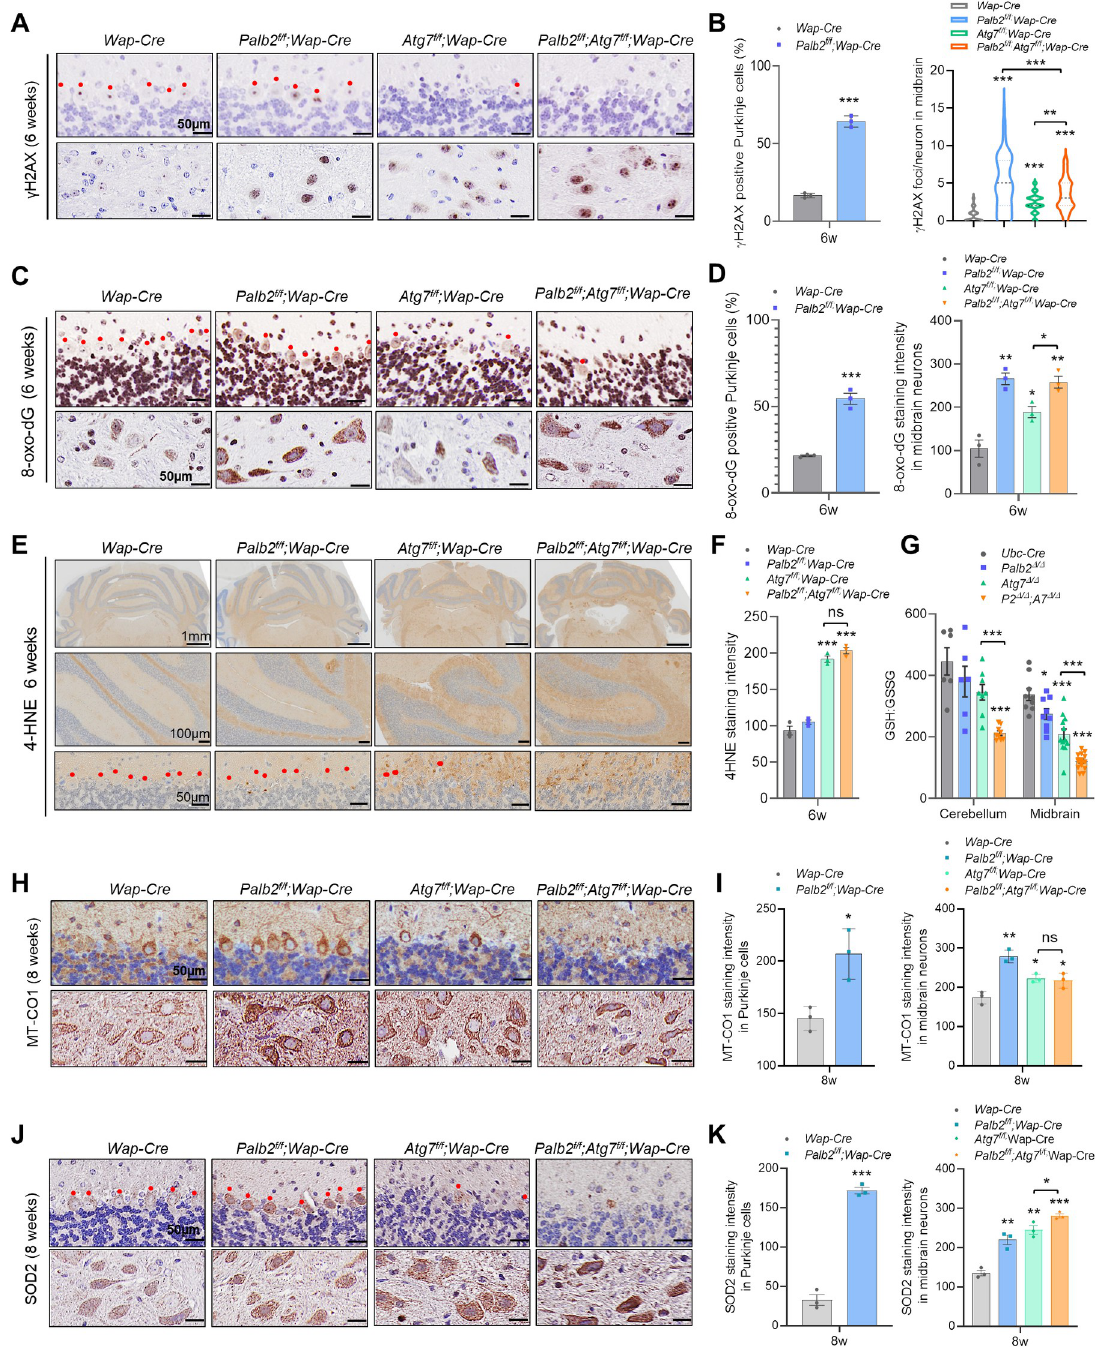
Fig 3. Increased DNA damage and oxidative stress and mitochondrial markers in Purkinje cells of Palb2 and Atg7 deletion mice. (A-D) Representative IHC images and quantification of DNA DSB marker γ H2AX (A and B) and oxidative DNA damage marker 8-oxo- dG (C and D) in cerebellum/Purkinje cells (upper images) and midbrain neurons (lower images) of the Wap-Cre driven CKO mice at 6 weeks. n = 3 mice per genotype. (E and F) Representative IHC images and quantification of lipid peroxidation marker 4-HNE in the cerebellum of the CKO mice at 6 weeks of age. Scale bar = 50 μ M. n = 3 mice per genotype. (G) GSH:GSSG ratios in the cerebellum and midbrain of Ubc-Cre-ERT2 driven WBKO mice. GSH and GSSG were measured by LC–MS/MS at 4 weeks after tamoxifen injection. n = 6–9 for cerebellum and n = 9–15 for midbrain. (H-K) Representative IHC images and quantification of MT-CO1 (H and I) and SOD2 (J and K) in cerebellum/Purkinje cells (upper images) and midbrain neurons (lower images) of CKO mice at 8 weeks. Red dots indicate Purkinje cells. Scale bar = 50 μ m. n = 3 mice per